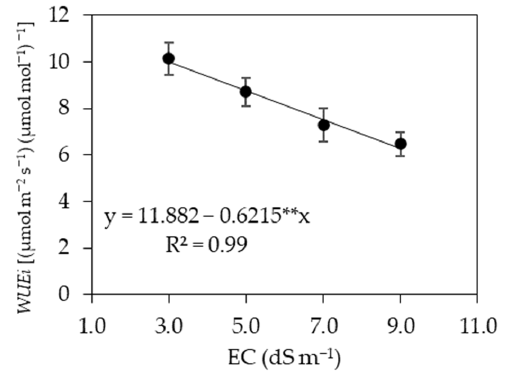
Figure 13. Instantaneous water use efficiency— WUEi of ‘Canindé’ okra cultivated in a hydroponic system as a function of the electrical conductivity of the nutrient solution (EC) 60 days after transplanting. ** Significant at p ≤ 0.01. The vertical lines represent mean +/ − standard error (n = 4). According to the summary of the analysis of variance, the interaction between the electrical conductivity of the nutrient solution and the concentrations of salicylic acid (EC × SA) significantly affected the initial fluorescence, maximum fluorescence, variable flu- orescence, and quantum efficiency of photosystem II of okra plants 60 days after trans- planting. The variables of initial fluorescence before the saturating pulse, the quantum efficiency of photosystem II, and the electron transport rate were significantly affected by the electrical conductivity of the nutrient solution 60 days after transplanting. When analyzing the effect of the interaction between the electrical conductivity of the nutrient solution and the concentrations of salicylic acid on the initial fluorescence of okra plants (Figure 14A), it was verified that the increase in EC promoted an increase in initial fluorescence at all concentrations of salicylic acid. This increase is intensified when SA concentrations above 1.5 mM are used, and the highest value of initial fluorescence (359.51) was observed in plants irrigated with EC 9.0 dS m − 1 and sprayed with SA at the concentration of 3.6 mM. ( A )